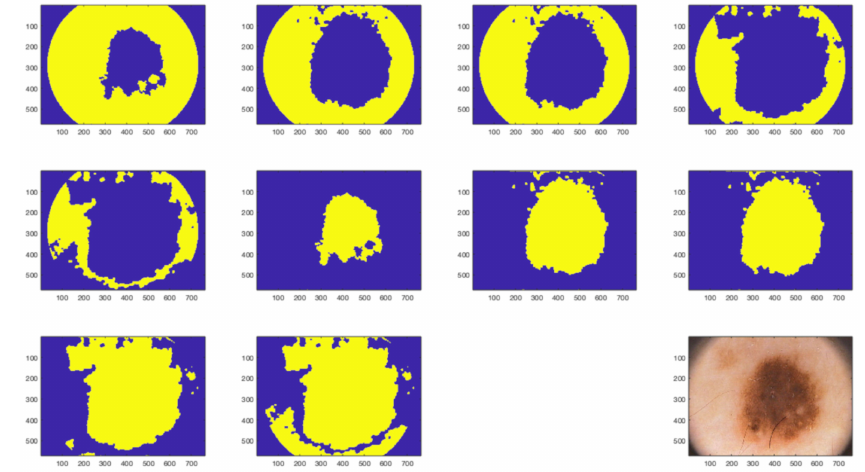
Figure 2. The segmented regions obtained by binary orthogonalization of BPS. The last image is the original image of the skin